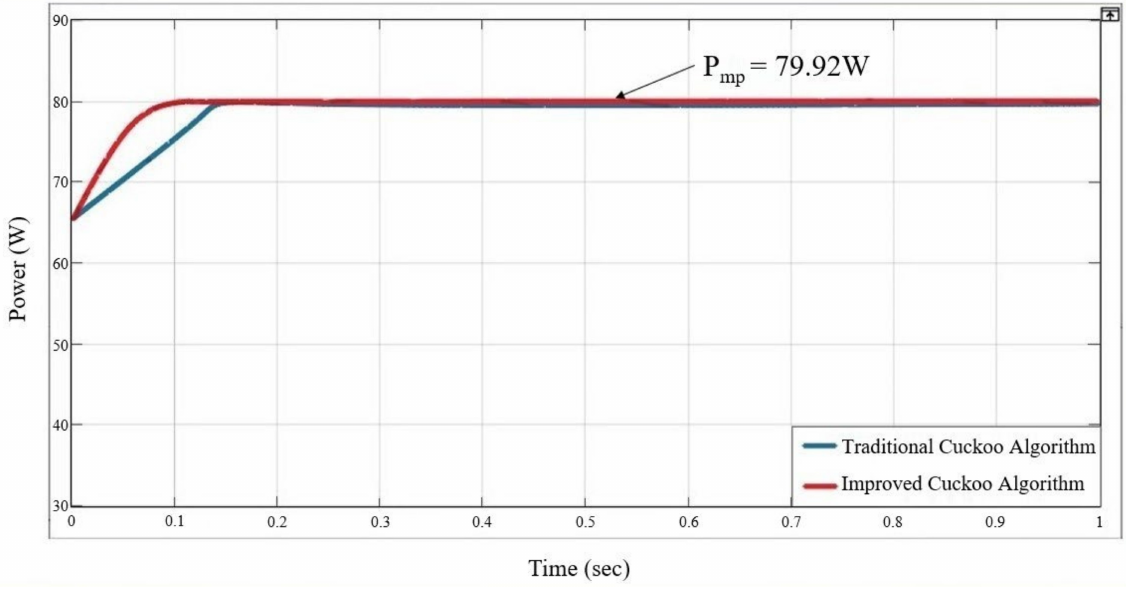
Figure 5. Simulation result of maximum power point tracking of traditional and improved cuckoo algorithm in Case